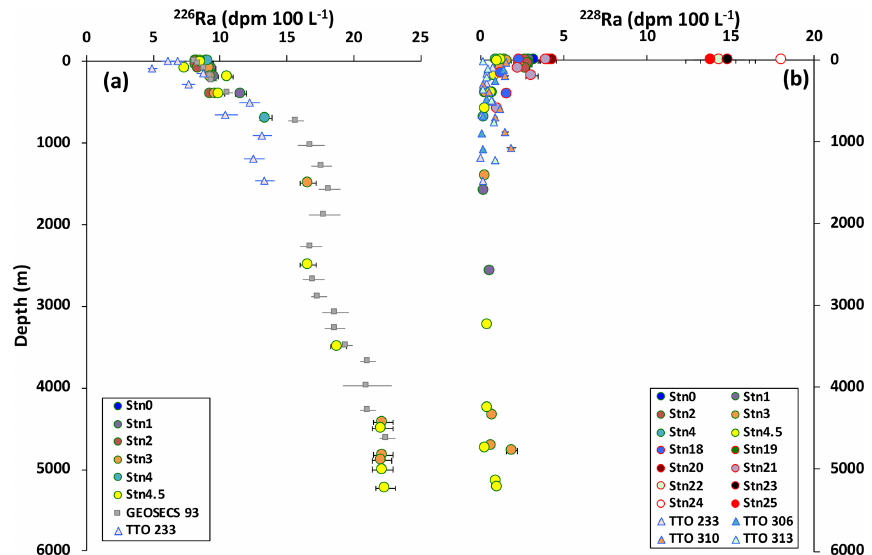
Figure 2. Depth profiles of (a) 226 Ra and (b) 228 Ra activities. The grey squares show Ra data from the previous GEOSECS study (Ku and Lin, 1976); the triangles show Ra data from the TTO programme (Key et al., 1990, 1992a, b). Different water masses are characterised in the (a) 226 Ra profile (see details in text). Error bars are ± 2